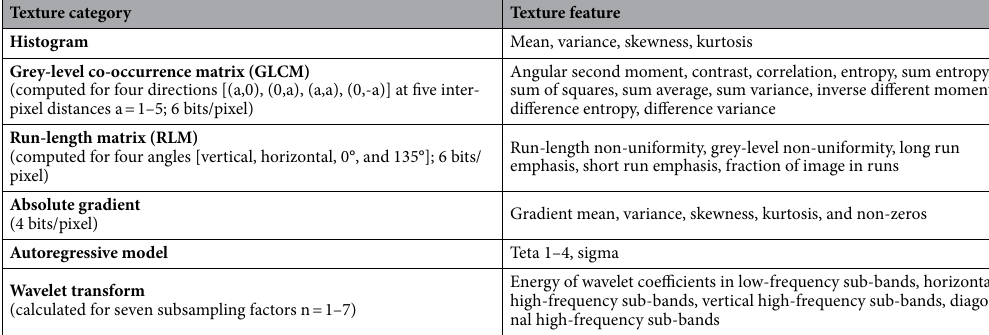
Table 1. Summary of all computed texture analysis categories with corresponding